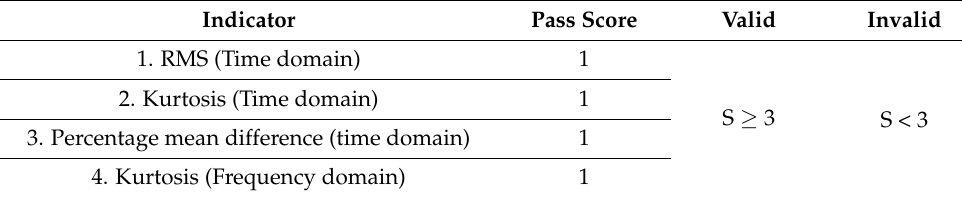
Table 2. The selected criteria for separating valid and invalid data sets. Indicator Pass Score